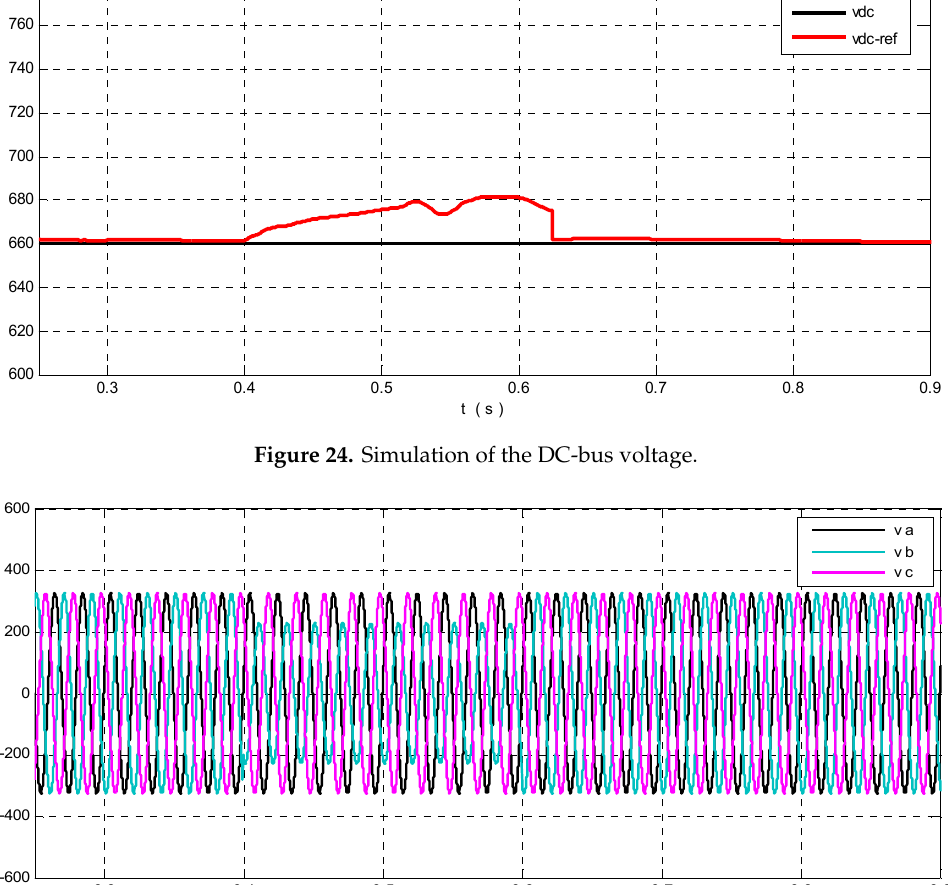
Figure 25. The grid voltage signals.